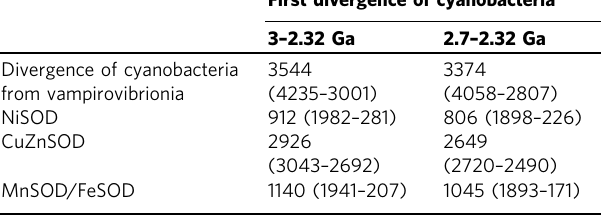
Table 2 Statistics summarizing divergence times predicted by molecular clock